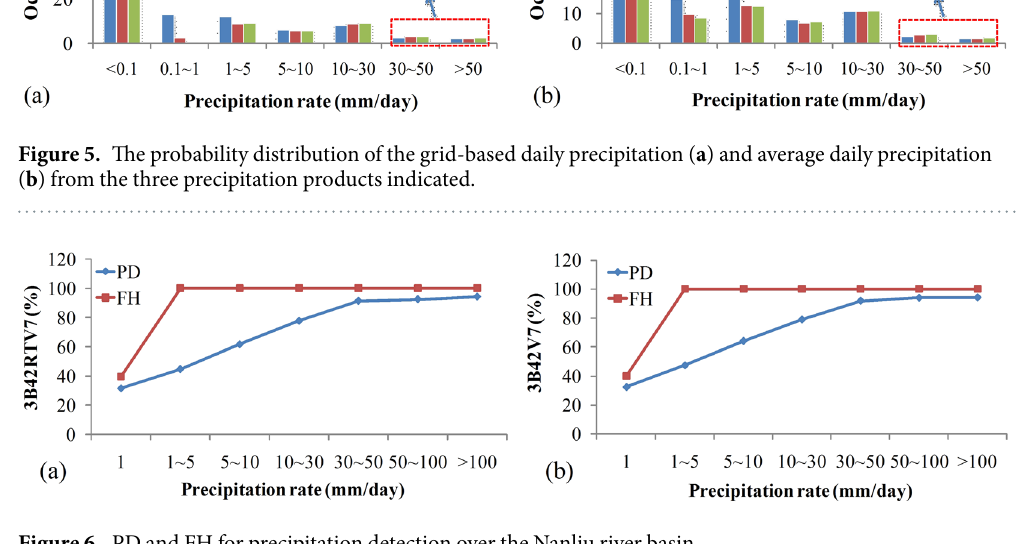
Figure 6. PD and FH for precipitation detection over the Nanliu river